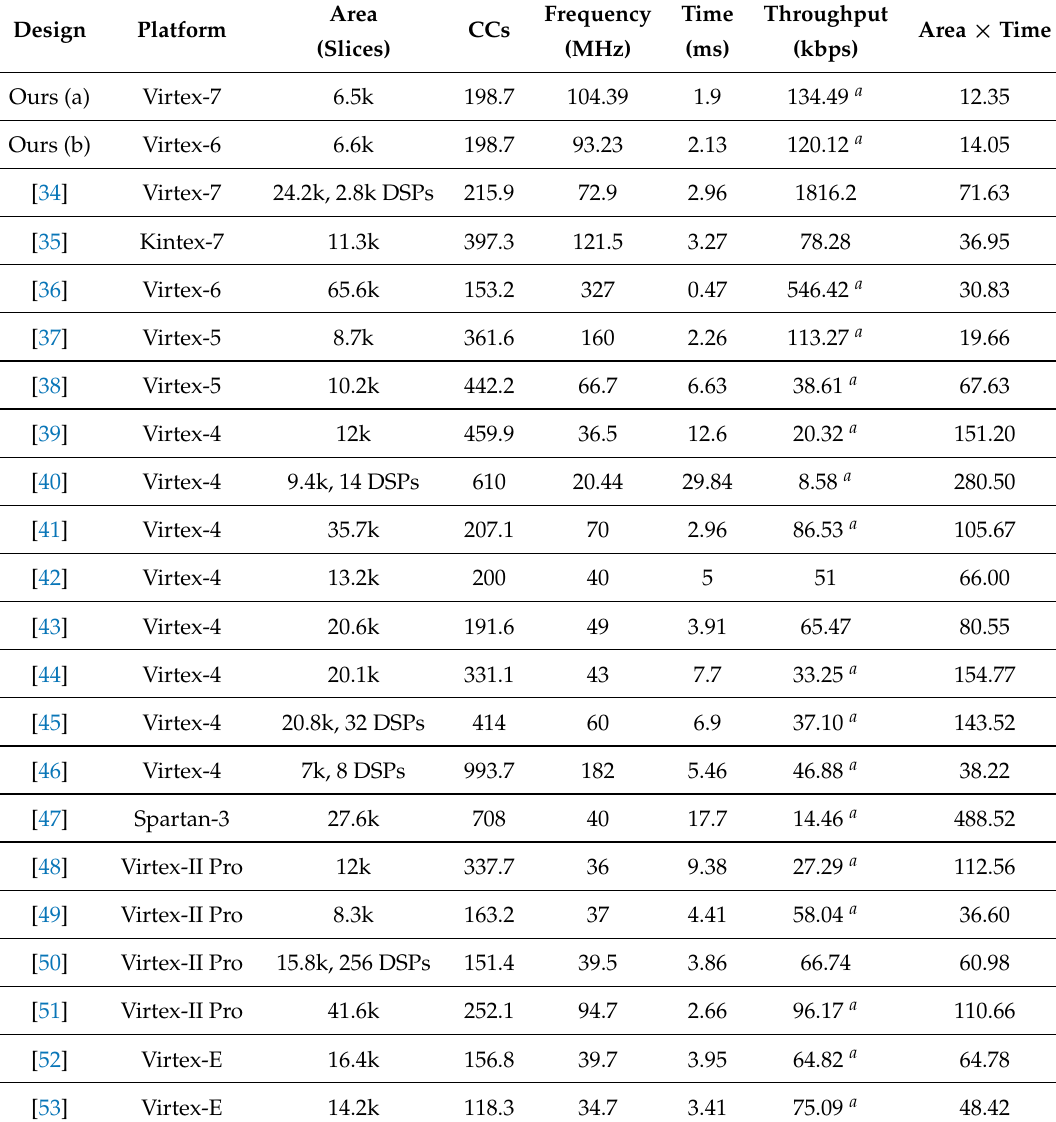
Table 2. Performance comparison of the proposed ECC processor with other related designs over F p